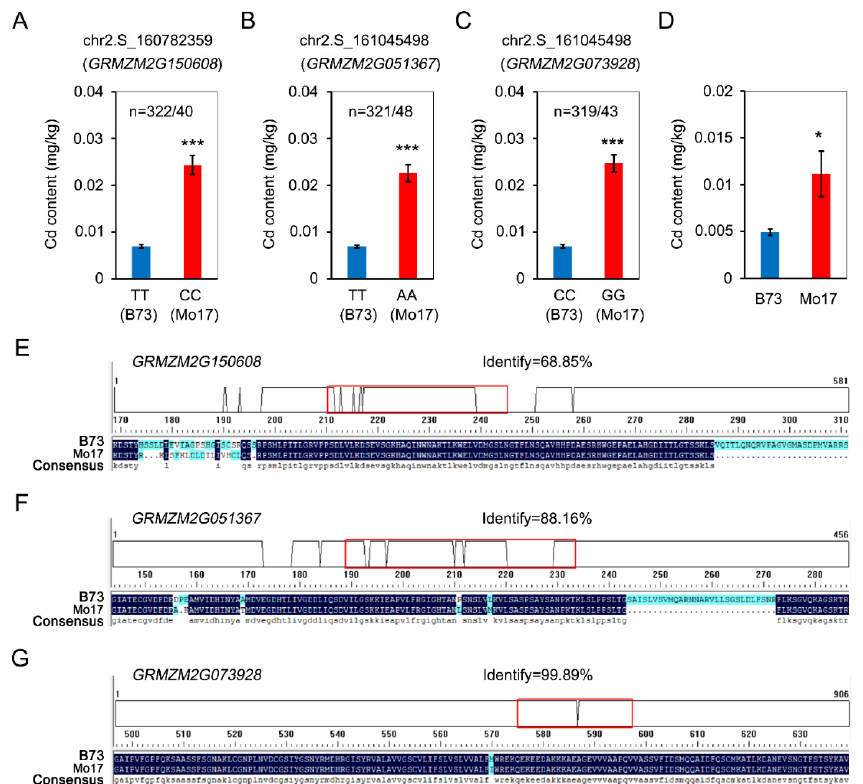
Figure 5. Phenotype analysis between the candidate genes for locus associated with Cd concentration in maize and phenotypic difference between different alleles. The number above the box represents the number of inbred lines homozygous for a determined allelic variant. ( A – C ) Two combinations of the minor and major between chr2.S_160782359 ( A ), chr2.S_161045498 ( B ) and chr2.S_161273716 ( C ) in GRMZM2G150608 , GRMZM2G051367 and GRMZM2G073928 region. B73 represent allele in B73; Mo17 represent allele in Mo17. Asterisk represents significant difference. *** p < 0.001 (Student’s t -test). ( D ) Cd content in B73 or Mo17. Asterisk represents significant difference. * p < 0.05 (Student’s t -test). ( E – G ) Amino sequence comparison of GRMZM2G150608 , GRMZM2G051367 and GRMZM2G073928 between B73 and Mo17.